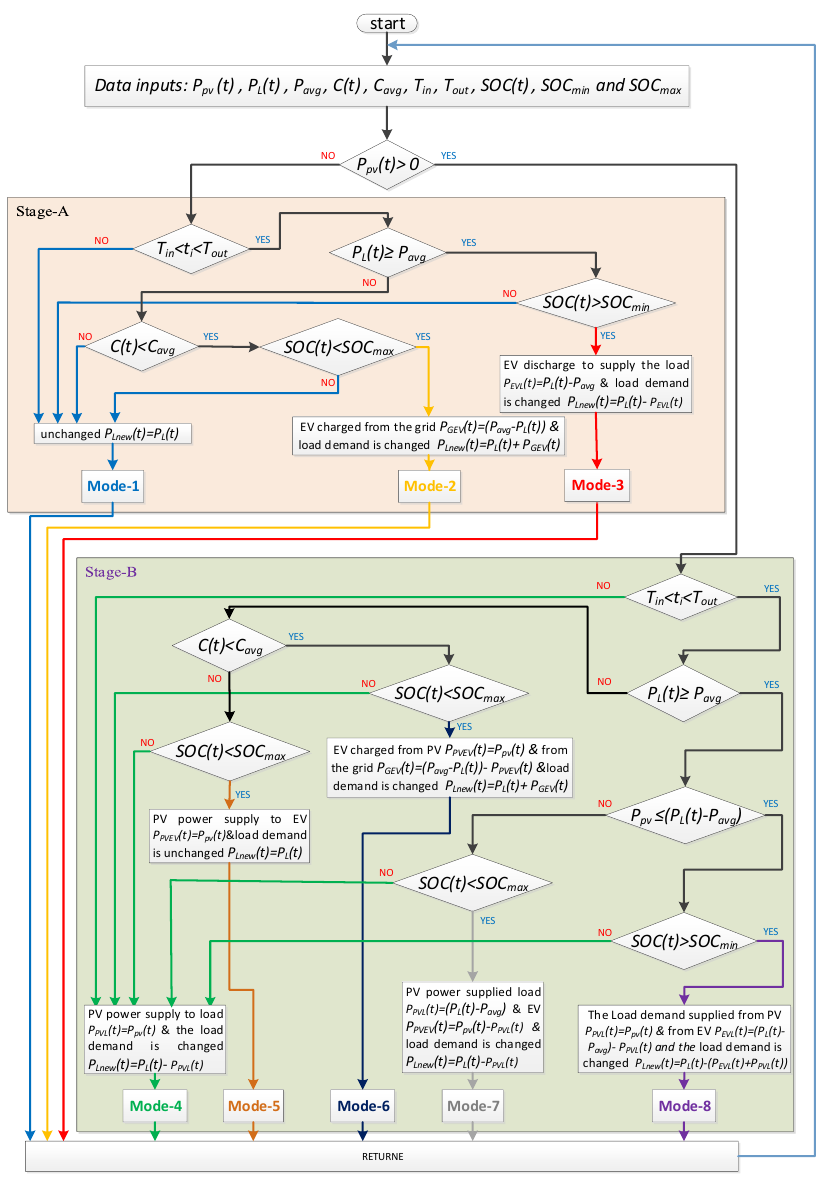
Figure 3. Proposed energy management strategy